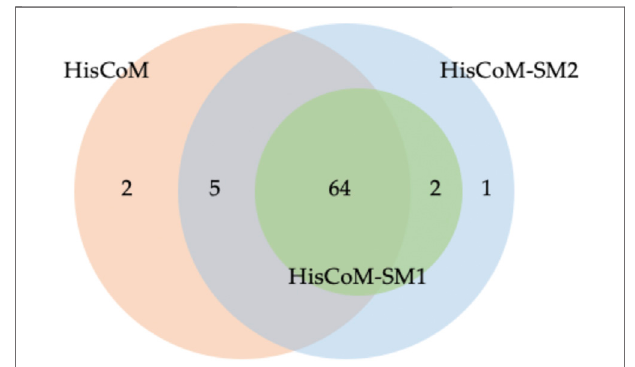
FIGURE4| Venn Diagramfor numbers ofsigni fi cantpathwaysdetected for each method. Note that HisCoM-SM1 represents HisCoM-SM(single) and HisCoM-SM2 represents